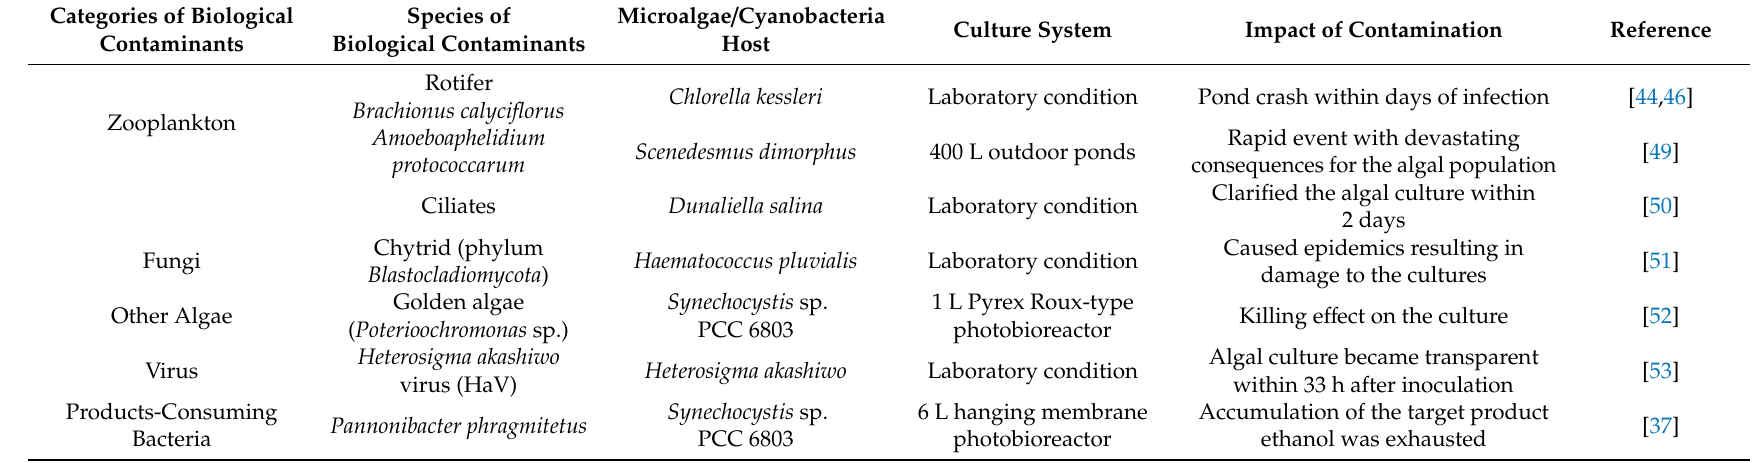
Table 1. Representative of biological contaminants in the cultures of microalgae and